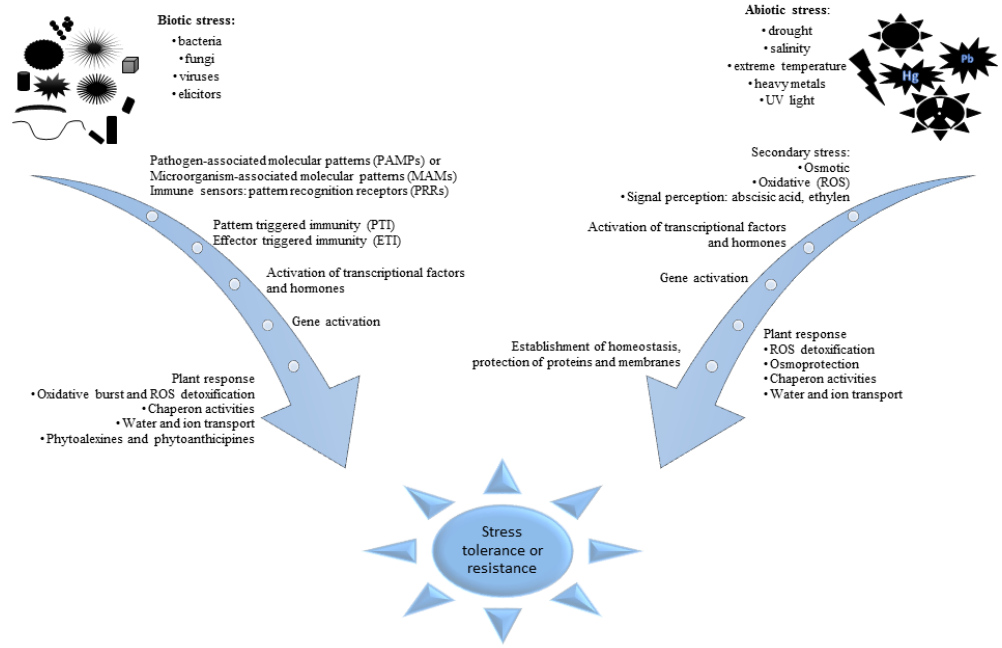
Figure 1. Stages of plant reactions to biotic and abiotic stresses. Particular processes can be specific to environmental stimuli. However, every of them leads to improvement of plant adaptation to stress and more effective response in future.